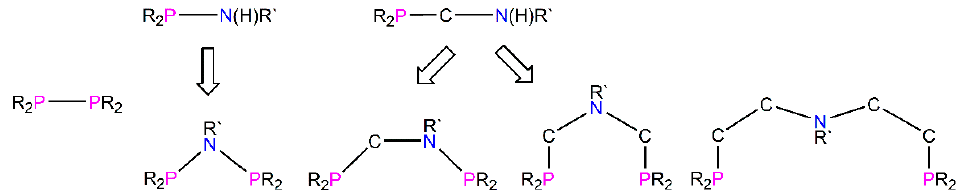
Figure 1. Cartoon illustration of some known diphosphines bearing a N atom in the backbone (R, R` = alkyl, aryl group).